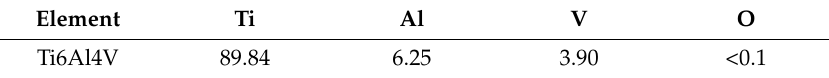
Figure 2. ( a ) The morphology of Ti6Al4V powder; ( b ) particle size and distribution. Table 2. Chemical composition of Ti6Al4V powder (wt Table 2. Chemical composition of Ti6Al4V powder (wt %).